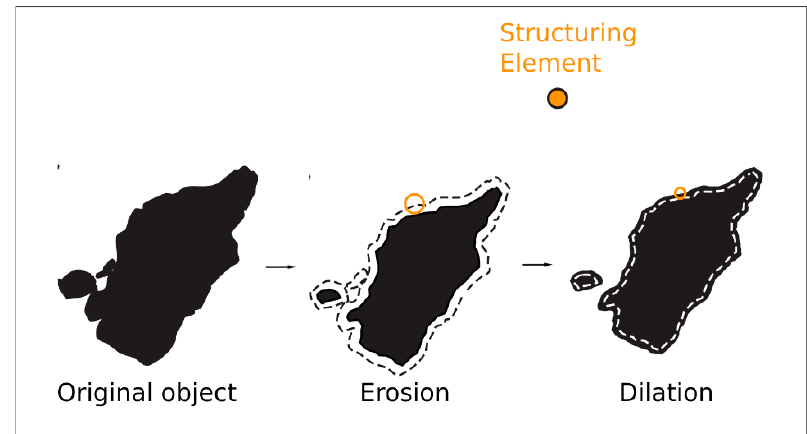
Figure 5. Schematic of morphology erosion and dilation.